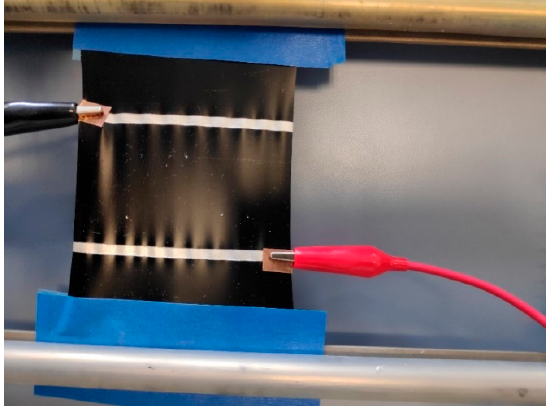
Figure 1. Sample mounted on a stretchable